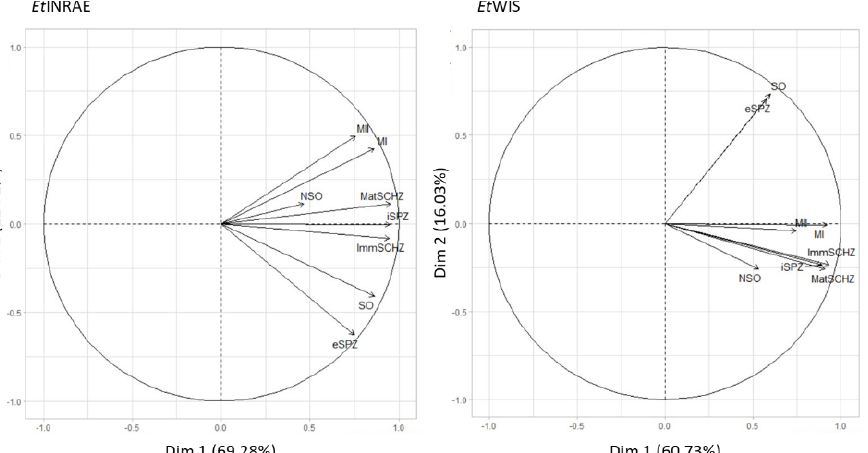
Figure 3. Principal component analysis (PCA) of rhoptry kinase transcription at different stages of development of the Eimeria tenella life-cycle. NSO non-sporulated oocysts, SO sporulated oocysts, eSPZ extracellular sporozoites, iSPZ intracellular sporozoites, ImmSCHZ immature schizont, MatSCHZ mature schizont, MI first-generation merozoites, and MII second-generation merozoites.